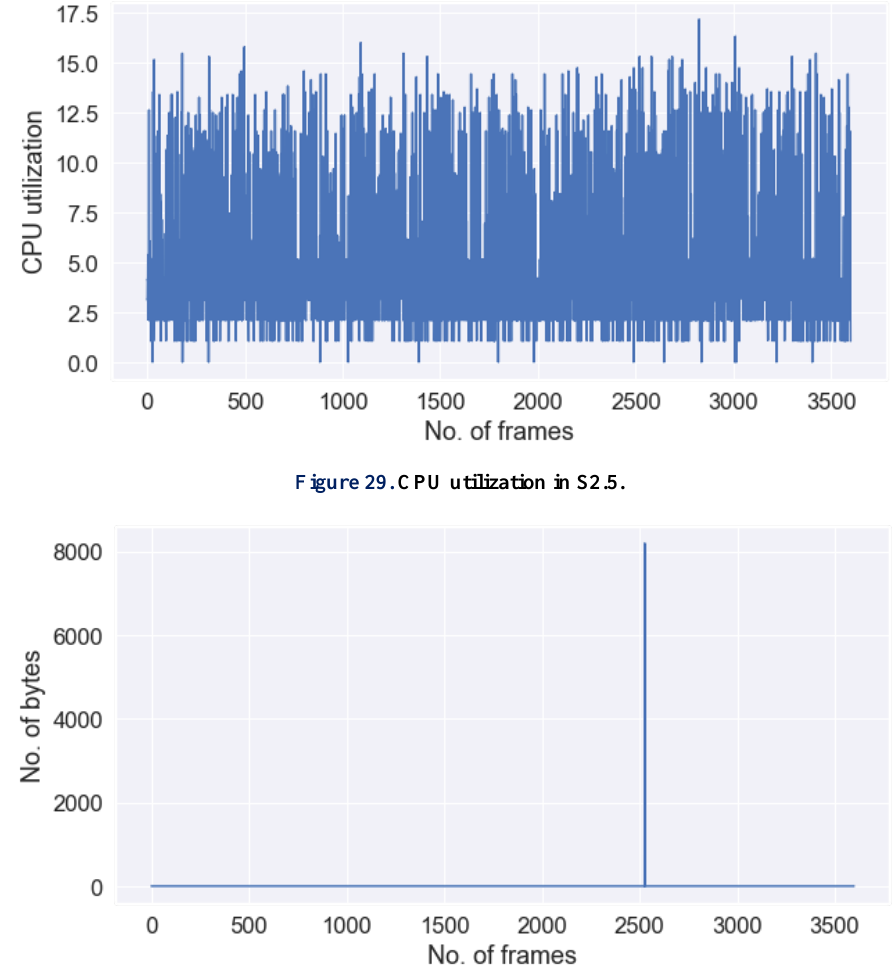
Figure 30a. Disk reads in